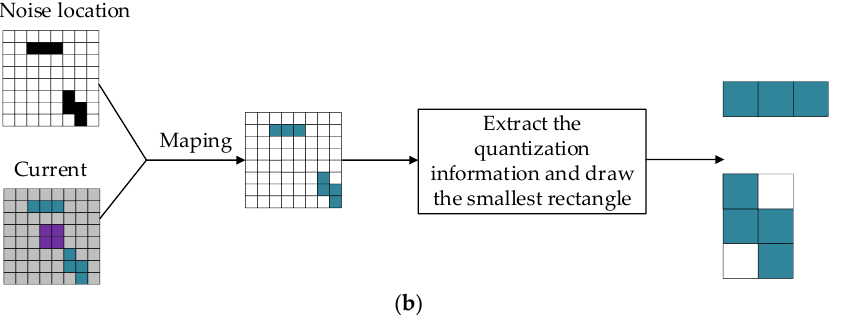
Figure 2. Image noise recognition and segmentation: ( a ) Detecting the location of noise; ( b ) Saving information about local